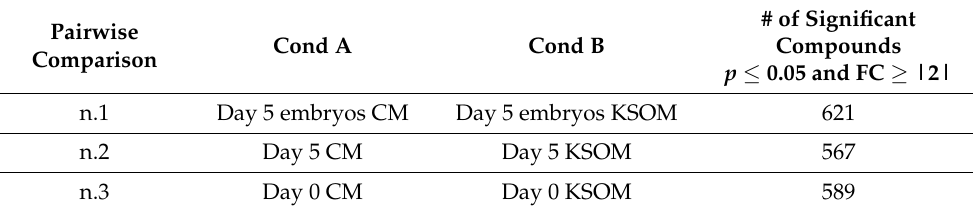
Table 1. Overview of differentially abundant metabolites in the pairwise comparisons, day 5 em-